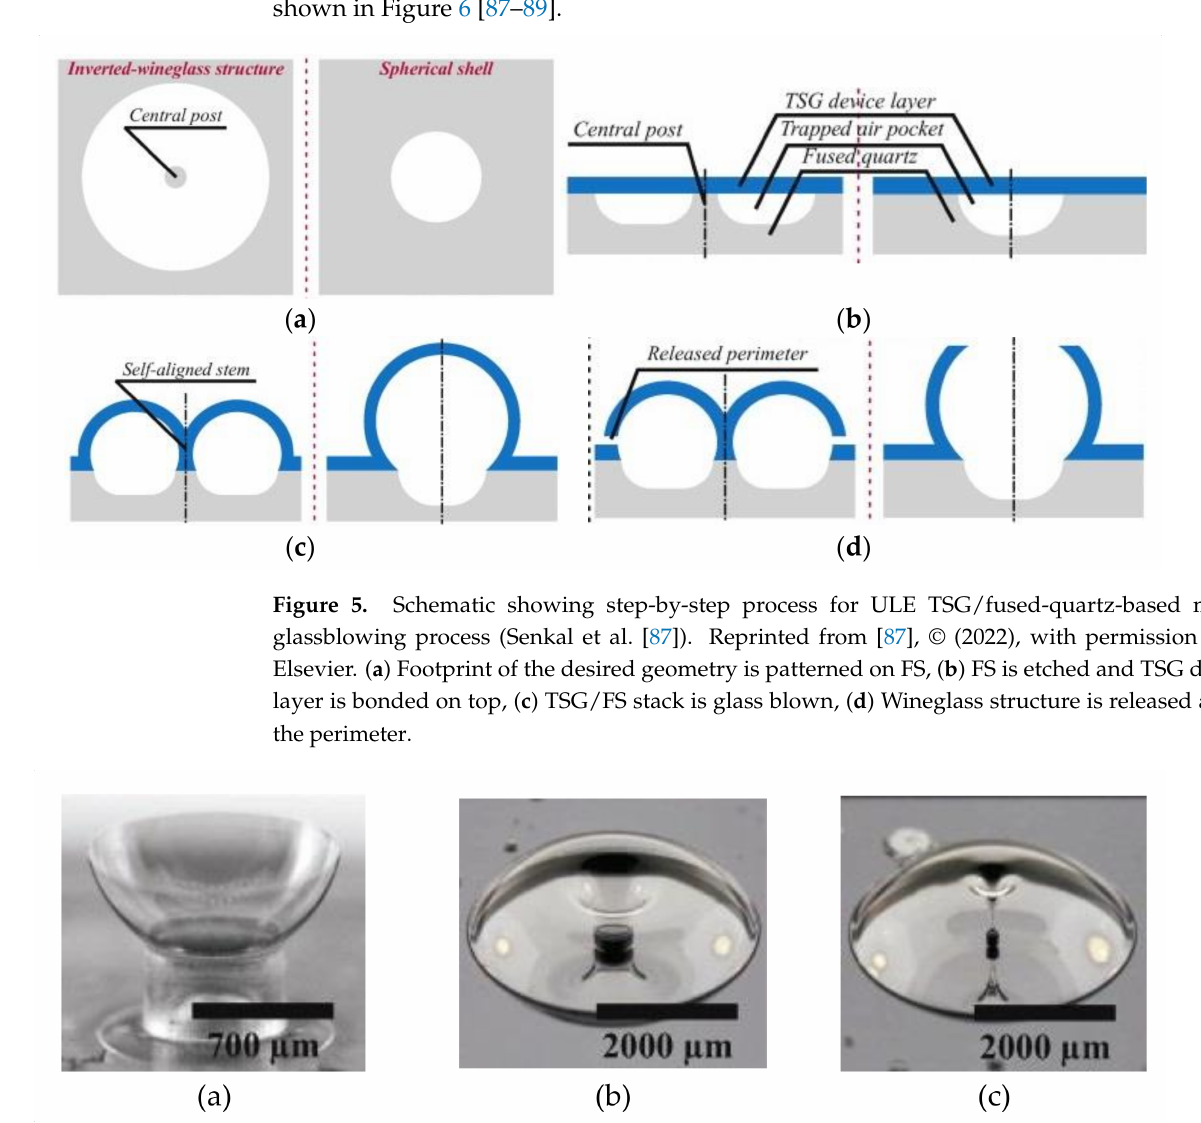
Figure 6. Pictures showing ULE TSG/fused-quartz final fabricated 3D wineglass and spherical shells (Senkal et al. [87]). Reprinted from [87], © (2022), with permission from Elsevier. ( a ) Hemisphere with hollow stem, ( b ) Hemisphere with solid stem of diameter 500 µ m, ( c ) Hemisphere with solid stem of diameter 60 µ